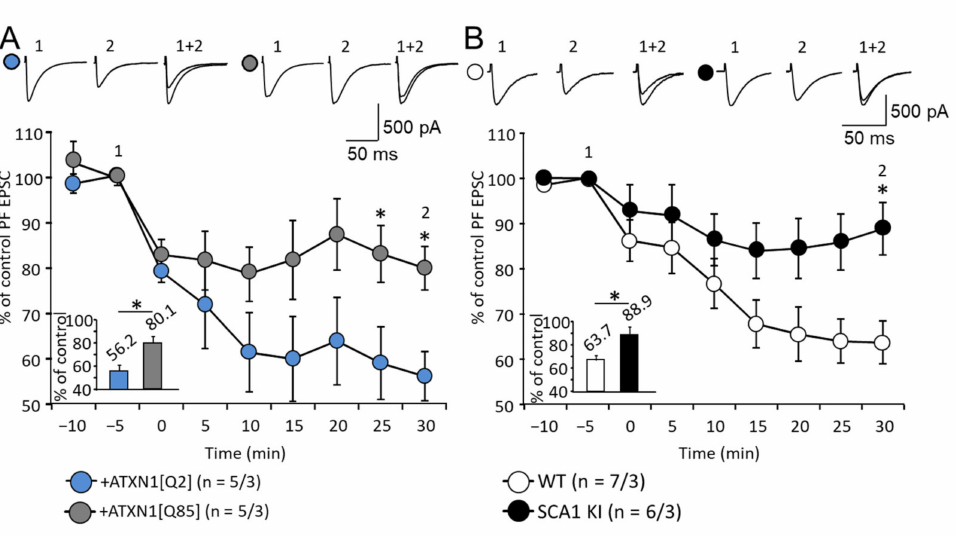
Figure 7. Impairment of LTD at PF-PC synapses in both SCA1 models. ( A , B ) Average time course diagram of PF EPSC amplitudes before and after LTD induction in mice that express ATXN1[Q85] selectively in BG ( A ) and in SCA1 KI mice ( B ). The amplitudes of PF EPSC were normalized to values before the LTP induction. The numbers ( n ) of tested PCs and animals (PCs/animals) are indicated in the graph. Representative PF EPSC traces are shown above the diagram. Time points: before (1) and 30 min after (2) LTD induction. PF EPSC averaged amplitudes 30 min after LTD induction are shown in the inserts. In both models, LTD was reduced. Asterisk indicates a statistically significant difference compared with respective controls ( t -test; * p <